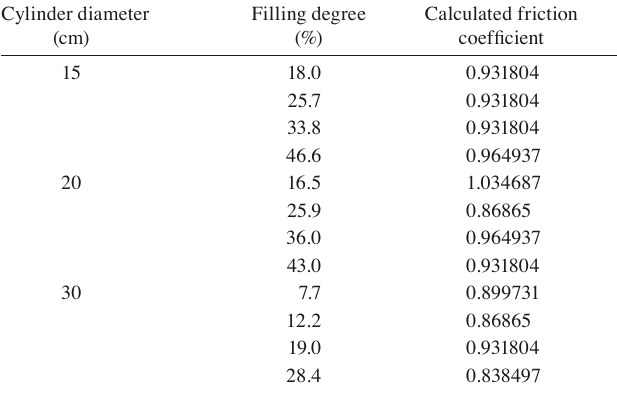
Tab. 5: Friction coefficient in rolling mode for rice grains and calculated values using Eq. (4). Cylinder